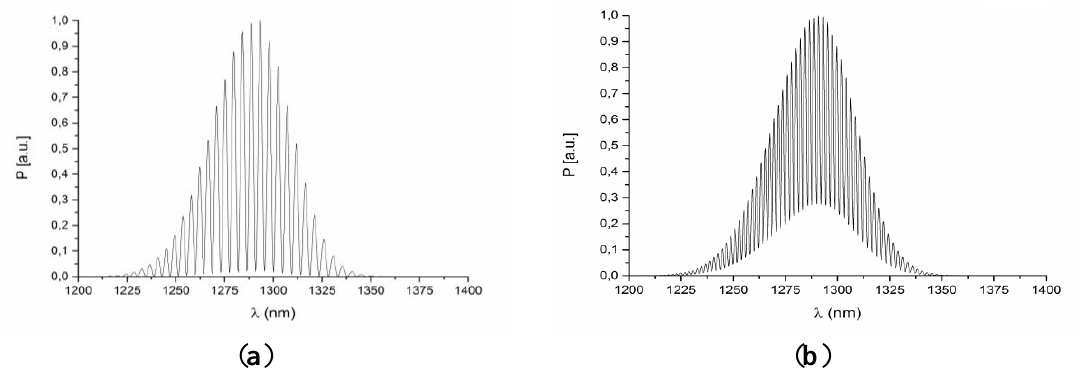
Figure 5. Measured: ( a ) reference signal; ( b ) signal from phosphate buffer saline.